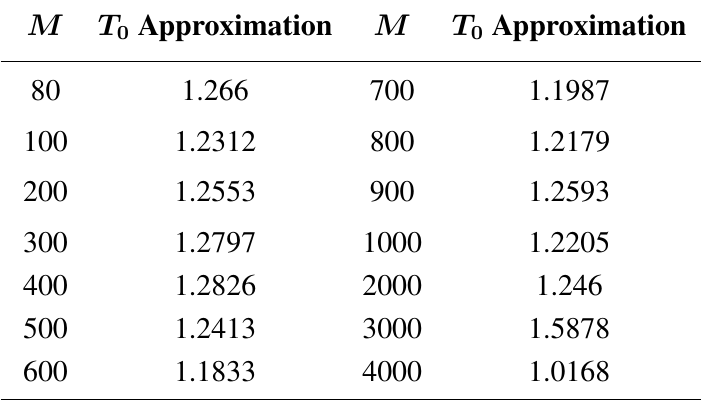
Table 7. Approximations of T (in ns) in the stripline example using extrapolations of fitted 0 quadratic error curves for various M . The closed form approximation of the time delay is T = 1 . 25809 ns, and the averaged value is T ( aver ) = 1 . 2669 ns for M ranging up to 3000 0 0